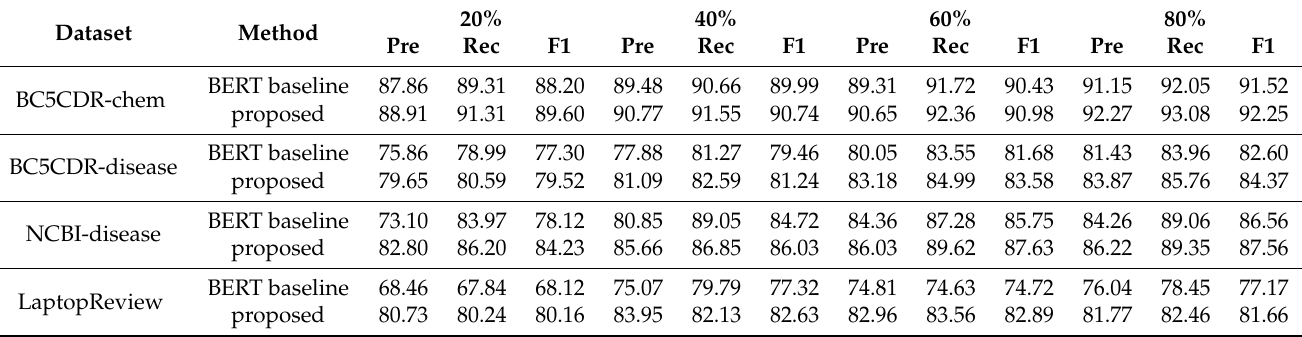
Table A1. Table of performance according to the size of strongly labeled data. Pre, rec, and f1 denote Precision, Recall, and F1-score,